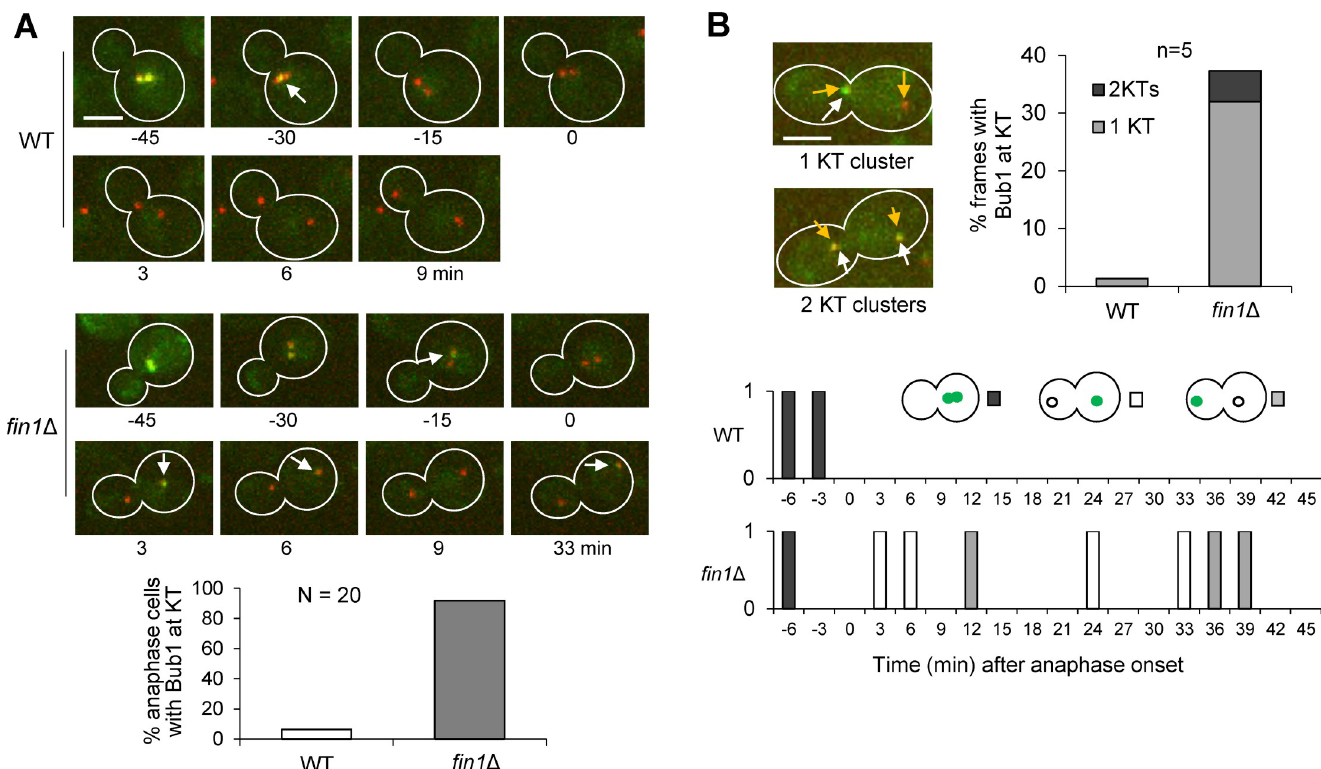
Fig 1. Fin1 promotes Bub1 dissociation from the kinetochore during anaphase. (A) Live-cell imaging of WT (2827-1-4) and fin1 Δ (3196-1-3) cells to show association of Bub1 with the kinetochore in anaphase. Log-phase WT and fin1 Δ cells with Bub1-GFP and Nuf2-mCherry in yeast peptone dextrose (YPD) medium were spotted onto the surface of a slide covered with agarose medium and subjected to live-cell microscopy. We set time 0 as the last point when the distance between two Nuf2-mCherry foci is less than 3 μ m. Arrows indicate Bub1-GFP Nuf2-mCherry co-localization. Cells that had Bub1-GFP co-localization with Nuf2-mCherry at any time during anaphase was counted as positive and the percentage of positive cells was graphed (n = 20). KT: kinetochore. (B) The co-localization of Bub1-GFP with the kinetochore after anaphase onset is dynamic. The localization pattern of Bub1 with single or both kinetochore clusters was counted for representative WT and fin1 Δ cells during anaphase (n = 5). Yellow arrows indicate kinetochore cluster; white arrows indicate Bub1 kinetochore localization. Scale bar, 2.5 μ m. The presence (1) or absence (0) of co-localization between Bub1-GFP and Nuf2-mCherry through the time course is shown in the bottom right panel.